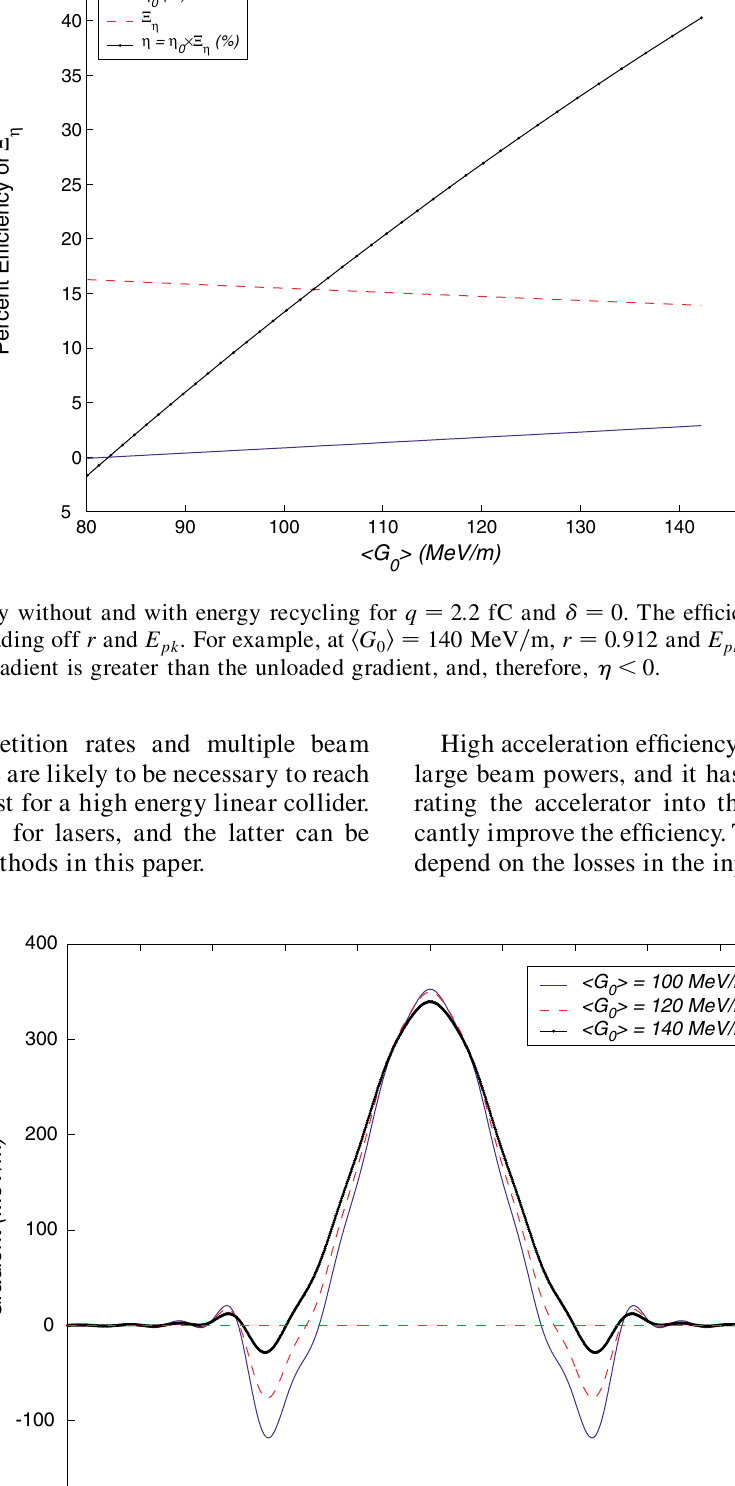
FIG. 7. (Color) Pulse shapes for different values of h G